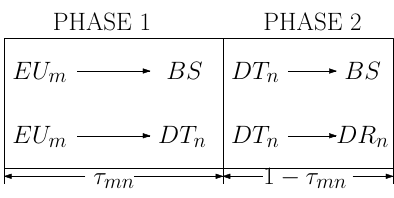
Figure 2. Time frame structure for